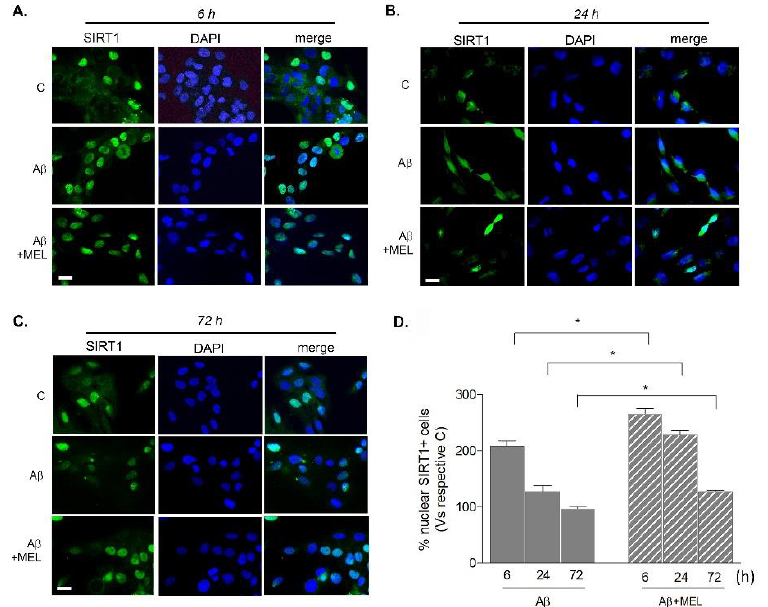
Figure 5. Time course of SIRT1 nuclear localization in HMC3 cells upon Aβ42 exposure. Cells were treated with 0.2 µM of Aβ42 alone or in combination with 1 µM melatonin (MEL) for 6, 24, or 72 h. In panels ( A − C ), representative images of immunostaining for SIRT1 (green) and nuclear counterstaining with DAPI (blue). Scale bar = 40 μm. In panel ( D ), graph reporting the percentage of nuclear SIRT1-positive cells over total SIRT1-positive cells, each vs. respective control, set as 100%. Results are the mean ± SEM of 3-5 independent experiments. * p < 0.05 vs. treatment with A β alone at corresponding time points (two-way ANOVA followed by Newman–Keuls test for signif- icance; treatment vs. time).